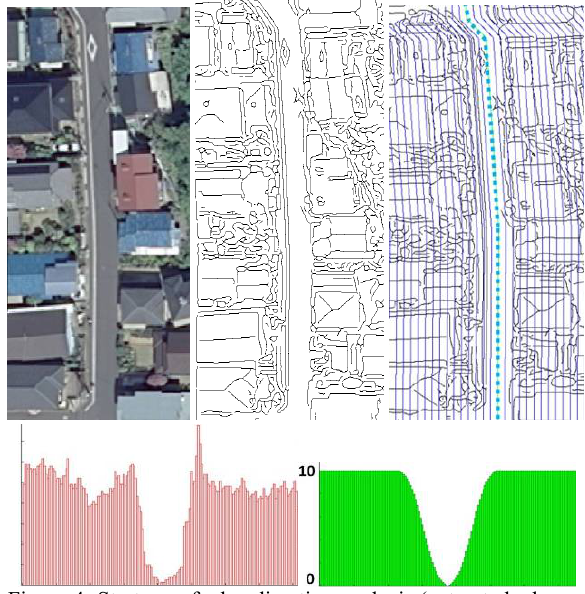
Figure 4: Strategy of edge direction analysis (extracted edges = black, expected road centre line = dotted cyan, parallel profiles = blue). Lower left: the computed histogram of the intersection counts over the profile index. Lower right: an optimal model